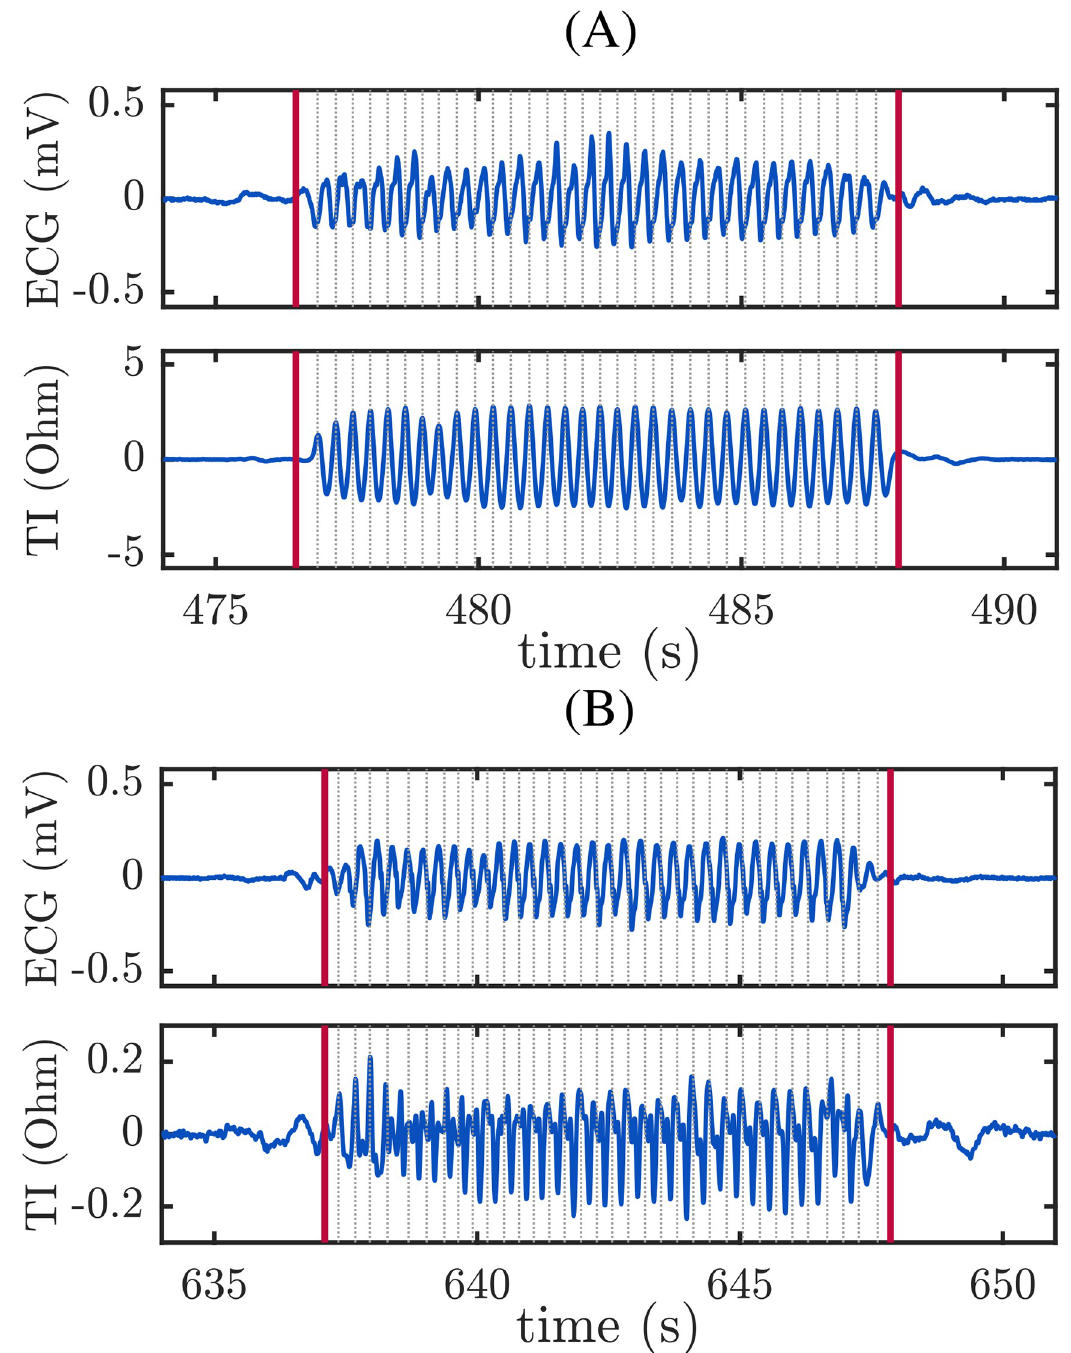
Fig 1. Examples of compression intervals identified in the AED signals. Intervals are delimited with vertical red lines. In both examples, oscillations caused by chest compressions are visible in the ECG (top) and the TI (bottom). Individual chest compressions are marked with grey dashed